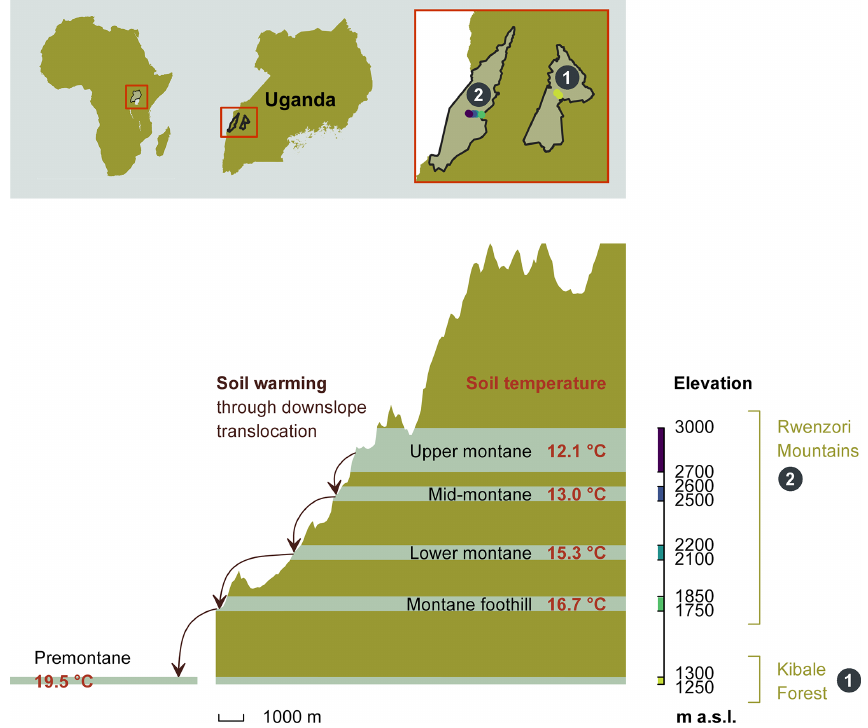
Figure 1. The height profile of the Rwenzori elevation gradient, starting from the nearby premontane Kibale Forest National Park (1250– 1300ma.s.l.) and on to the Rwenzori Mountains National Park (1750–3000ma.s.l.). Mean annual in situ temperatures for each of the five elevation clusters are indicated. The set-up of the in situ warming through the downslope translocation of soil cores to the immediate lower- elevation cluster is illustrated on the left side of the scheme. Different colours on the elevation axis represent the colour code for each elevation cluster throughout the